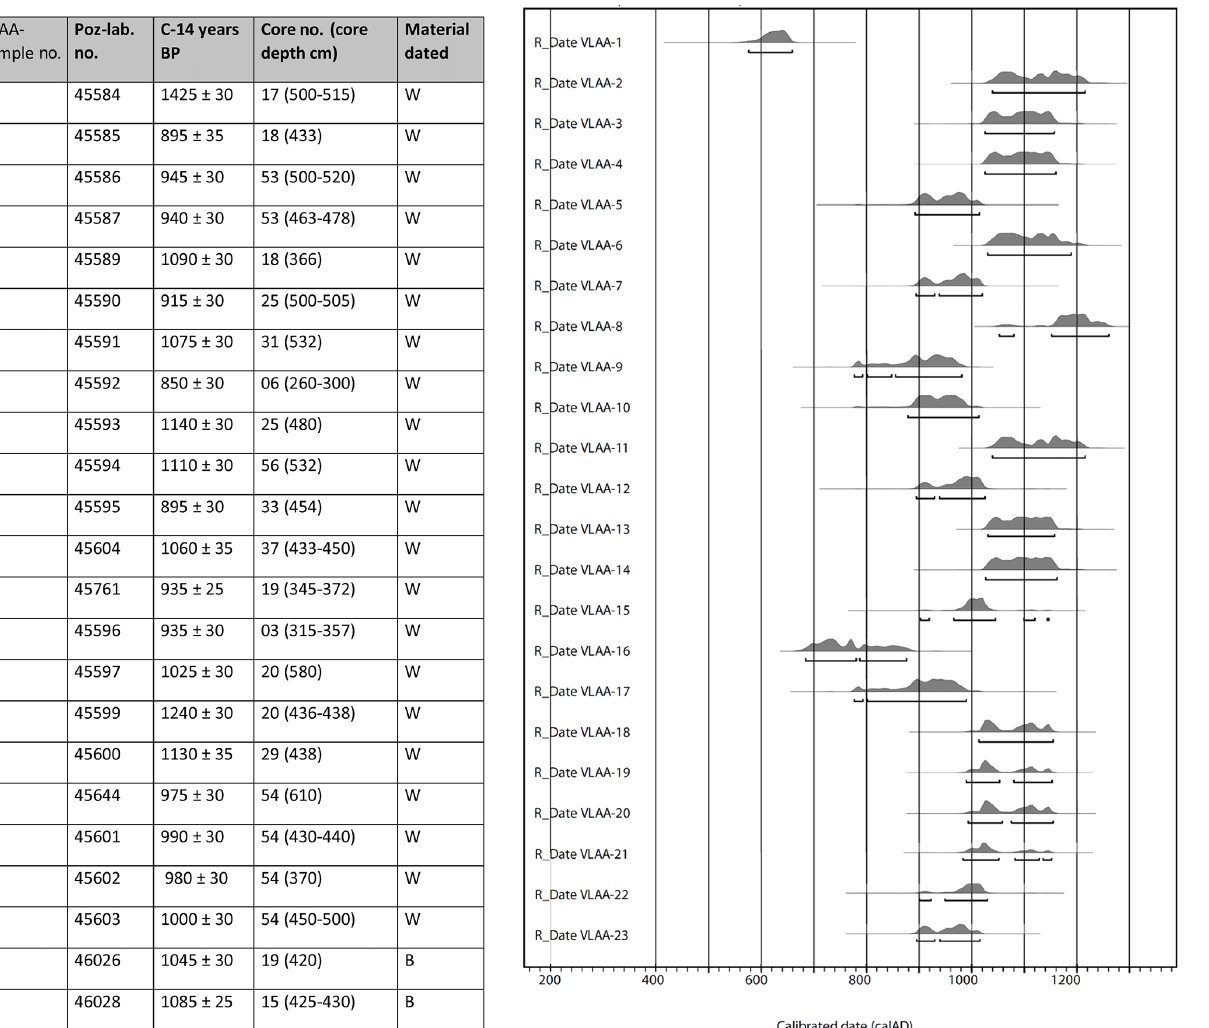
Figure 3. AMS radiocarbon dates; material dated: W – wood, B – bone.